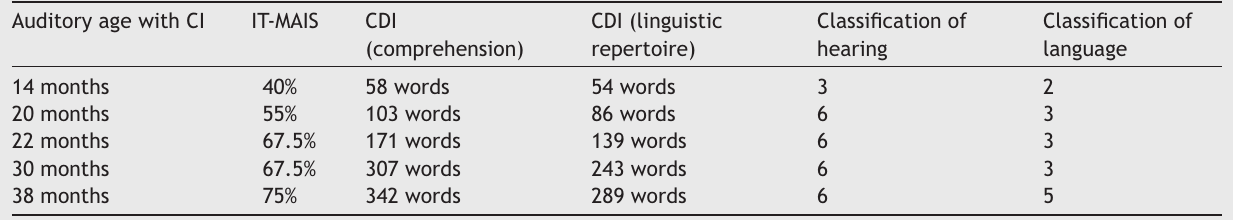
Results of IT-MAIS and CDI tests and classifications of hearing and language of participant D. Auditory age with